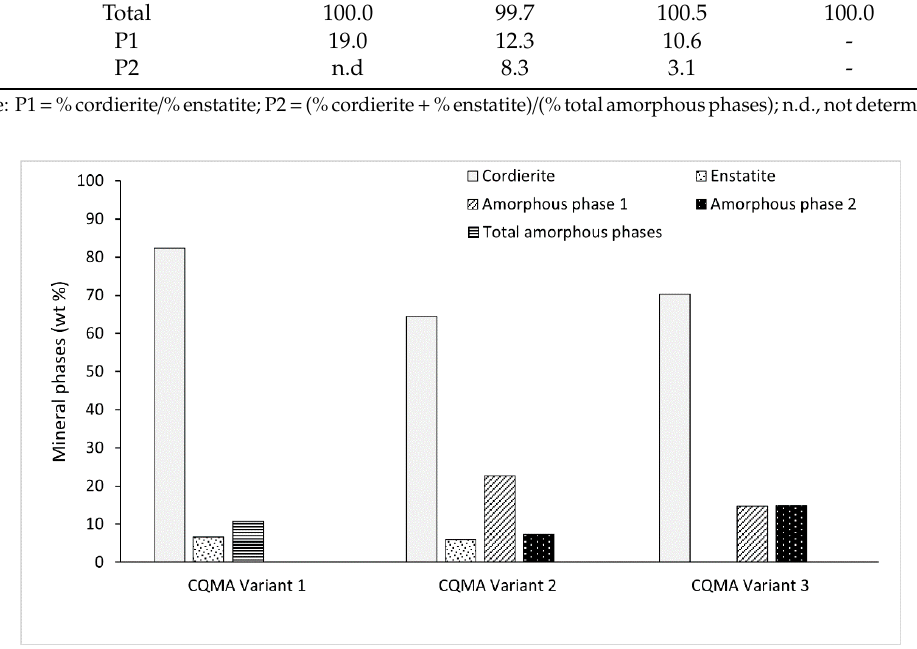
Figure 5. Comparison of calculated percentages for variants 1–3 determined by CQMA (option B).